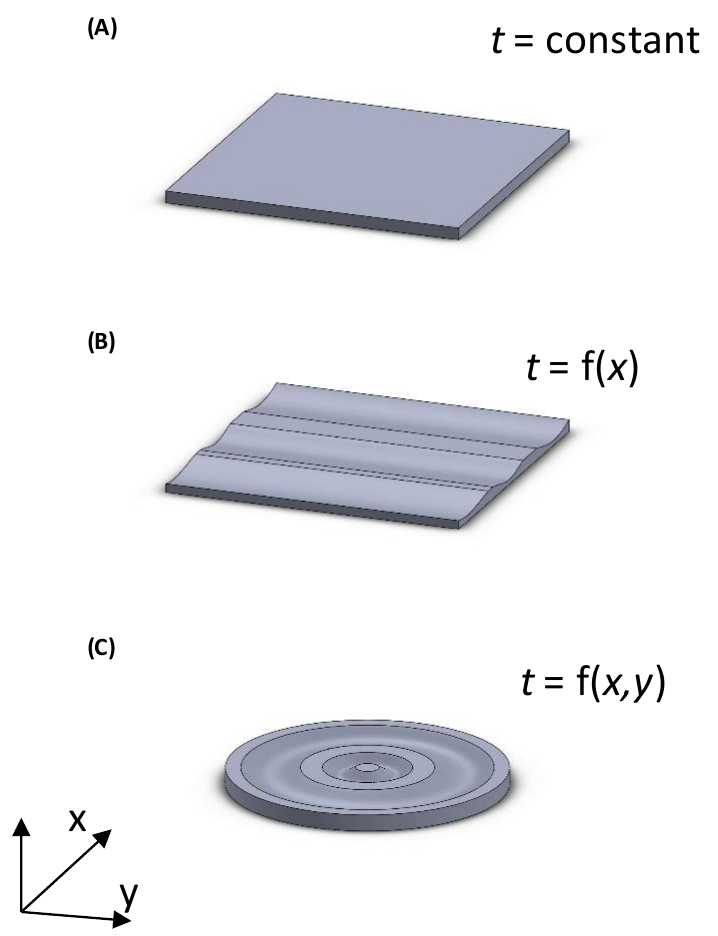
Figure 3. Types of sheets that can be used: ( A ) constant thickness; ( B ) spline thickness variation on x direction and ( C ) concentric thickness variation (direction x , y ).